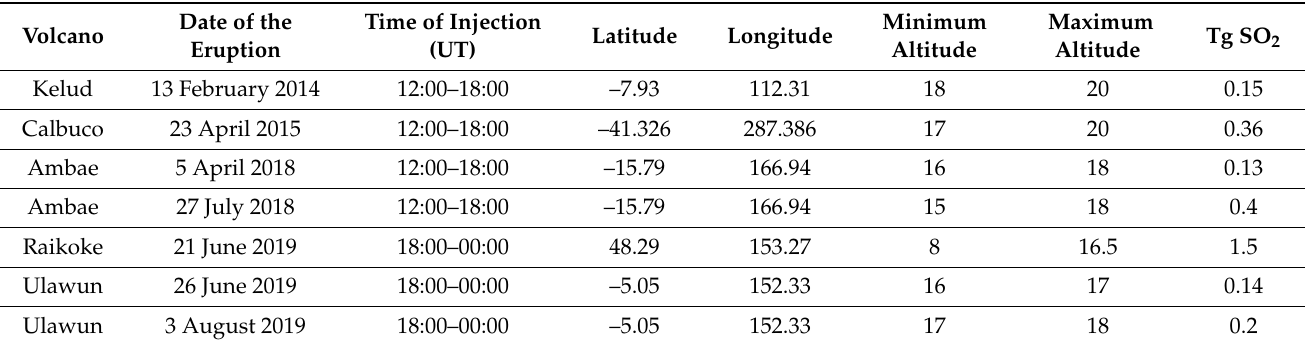
Table 1. Characteristics of each volcanic injection in the WACCM-CARMA model (date, volcano loca- tion, altitude range, and amount of SO 2 ). The injection parameters for the Kelud and Calbuco erup- tions are based on the information provided by Vernier et al. (2016) [85] and B è gue et al., 2017 [24]. For the Ambae plume, we take information from Kloss et al. (2020) [41]]. For the Raikoke and Ulawun events we base the injection set-up following Kloss et al. (2021)